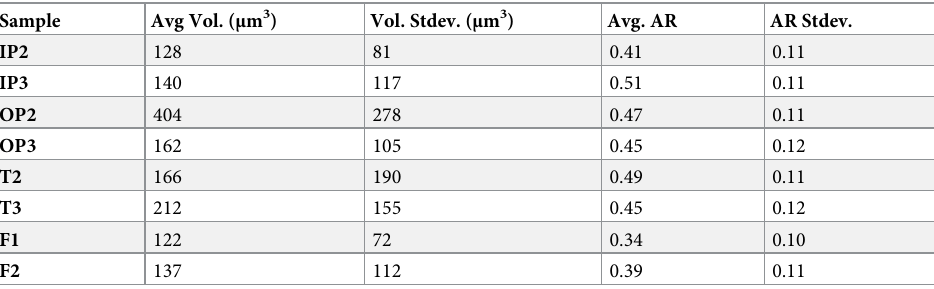
Table 2 shows OL average volume (Avg. Vol.) and average aspect ratio (Avg. AR) measurements of osteocyte lacunae segmented labels, together with their standard deviations (Stdev.) The data shown are obtained from the mean thresholding segmentation method (MT) for OL volume ranges between 20 and 2000 μ m 3